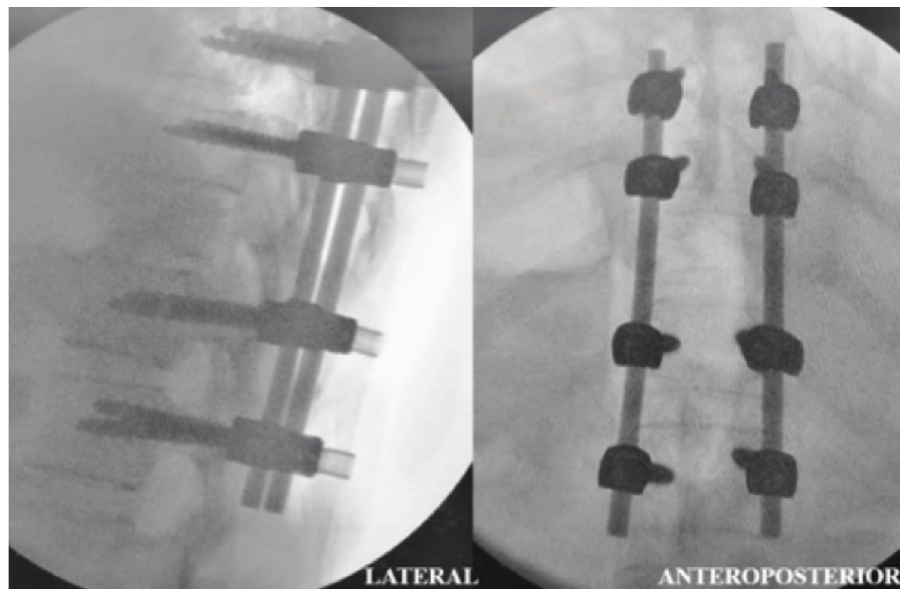
Fig. 2: Intra-operative spinal image intensifier (II) view after posterior instrumentation. All pedicle screws are well positioned and there is no scoliotic or kyphotic